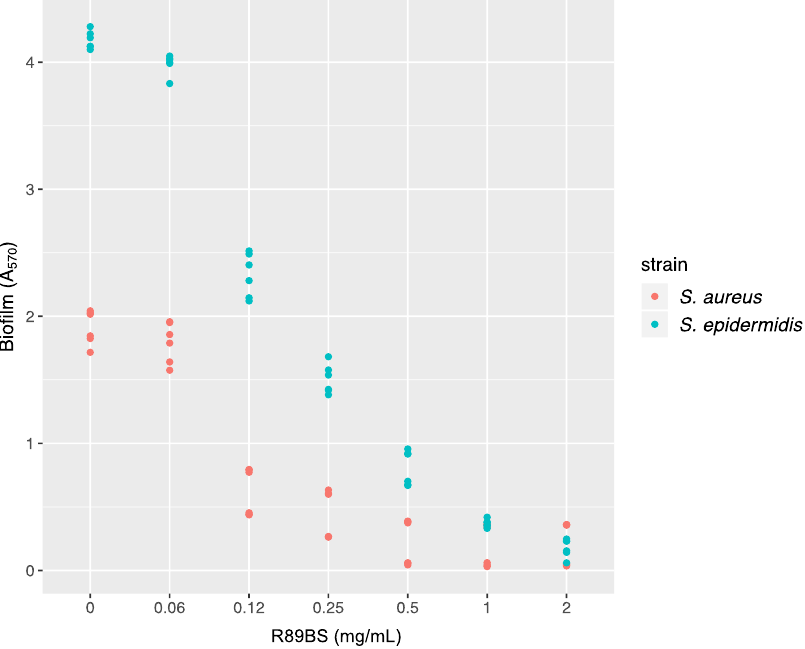
Figure 2. Staphylococcus spp. biofilm disruption by R89 biosurfactant (R89BS). S. aureus and S. epidermidis pre-formed biofilms were co-incubated with R89BS at concentrations ranging from 0.06 to 2 mg/mL. The disrupting activity of R89BS on Staphylococcus spp. biofilms was evaluated after 24 h at 37 °C. Dots (six for each concentration) represent single experimental data.